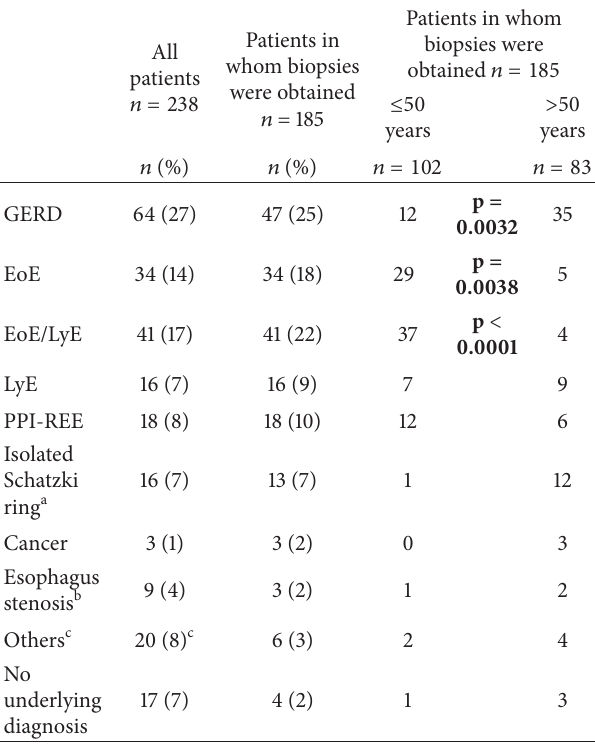
Table 1: Aetiology of esophageal food impactions in all 238 patients and in 185 patients with obtained biopsy samples from the esopha-